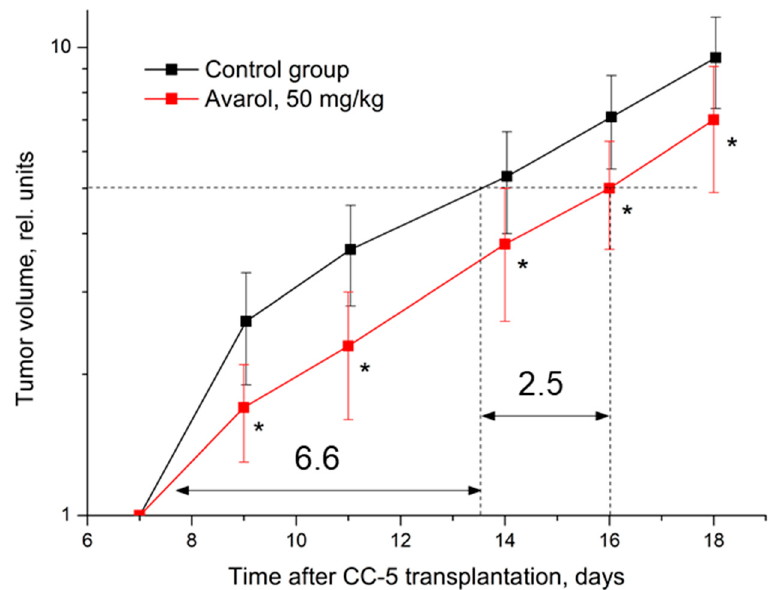
Figure 3. Influence of avarol on the dynamics of CC-5 growth. Graphic deviations correspond to SDs; *—statistically significant difference in tumor volume compared to control. Dotted lines—assessment of the duration of growth retardation (days) in the time of a five-fold increase in tumor volume. Arrows (and numbers next to them) indicate a graphical estimate of the time of a five-fold increase in the volume of the tumor node.